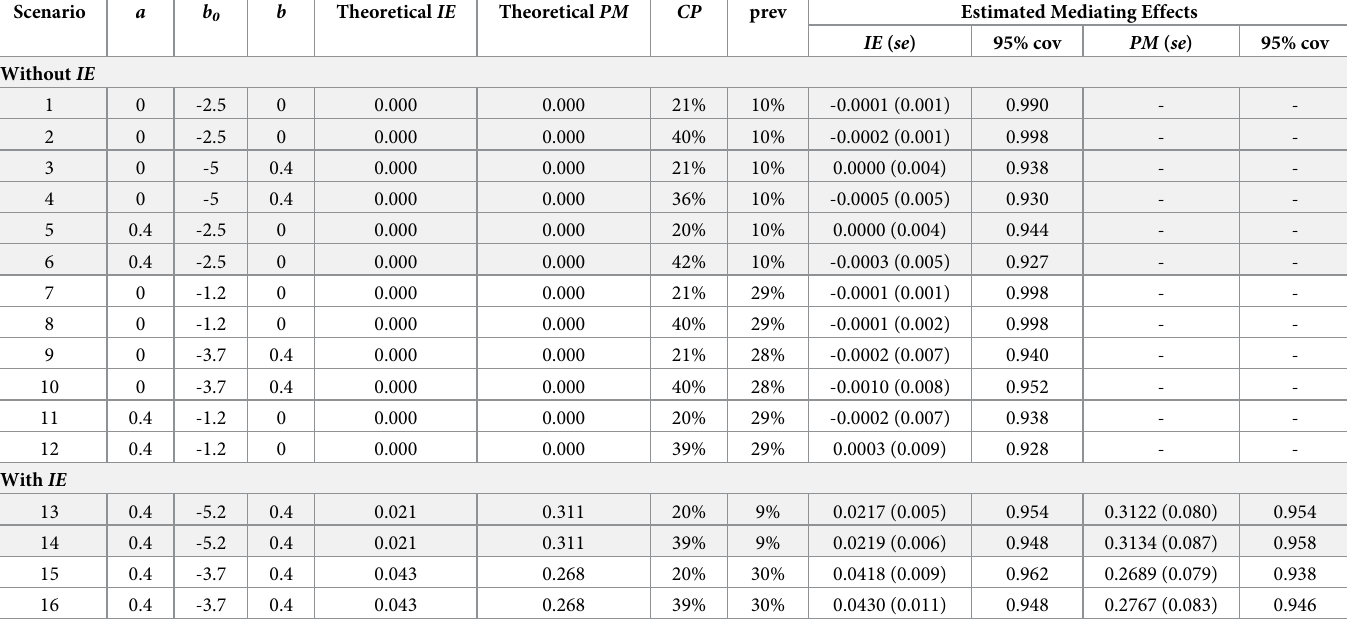
Table 2. Binary outcome: Means and standard errors (se) of indirect effects ( IEs ) and proportions of the total effect mediated ( PMs ); and coverage probabilities (cov) of the 95% confidence intervals for the estimations of IE and PM , given the minor allele frequency (MAF) = 0.3.